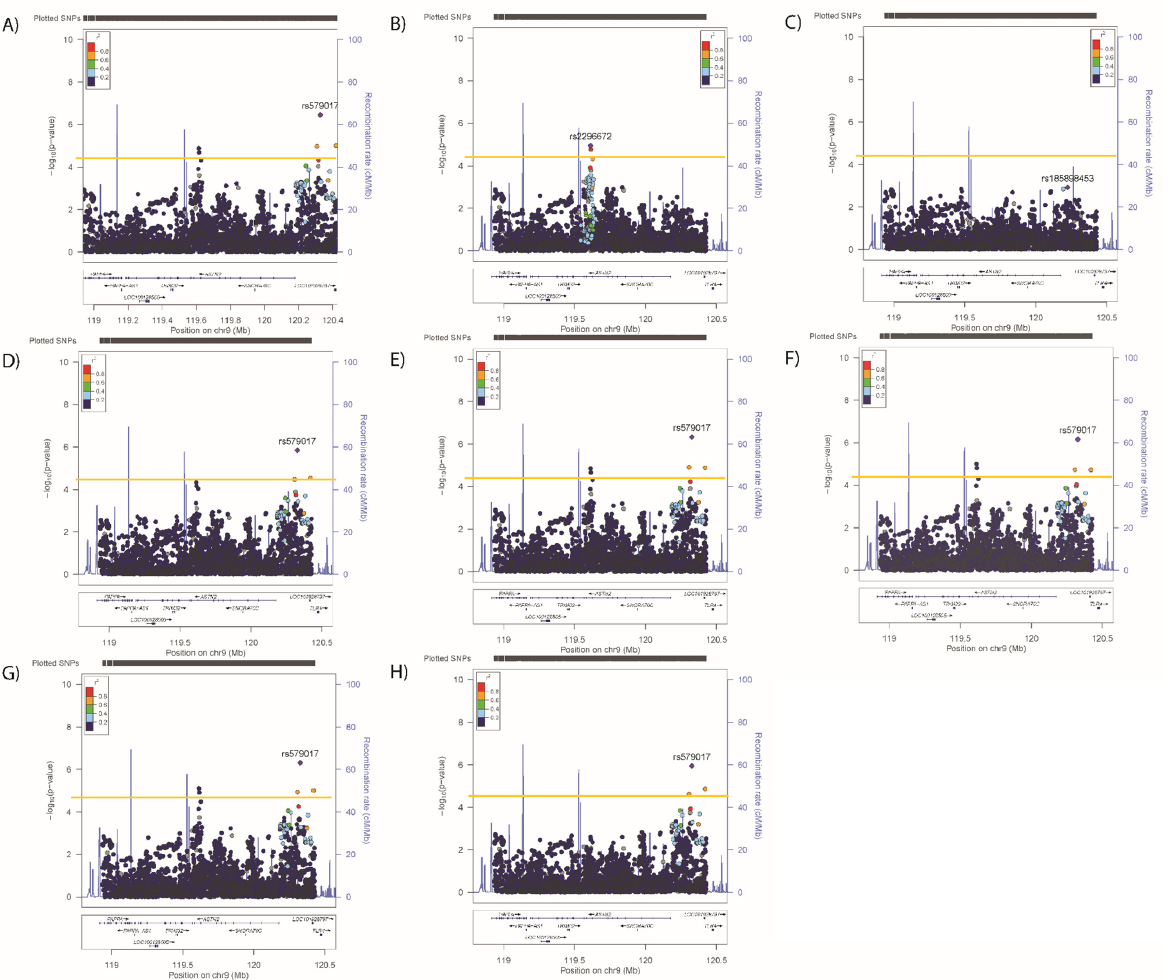
Figure 6. Results of associations between ASTN2 and ( A ) neuroticism, adjusted for the primary SNP for ( B ) neuroticism, ( C ) primary and secondary SNPs for neuroticism, ( D ) primary SNP for SBP/DBP, ( E ) BMI, ( F ) WHRadjBMI, ( G ) anhedonia and ( H ) mood instability. Significance was set at p -value < 5.45 × 10 − 5 or − log10 > 4.26 (Horizontal yellow line). LD (r2) with the lead SNP are indicated by colour. Grey indicates that there is no LD information available.